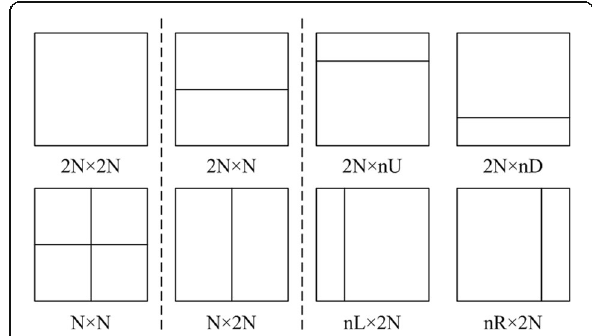
Fig. 1 The eight PU partitions. Left: square partition (SP); middle: symmetric partition (SMP); right: asymmetric partition (AMP)